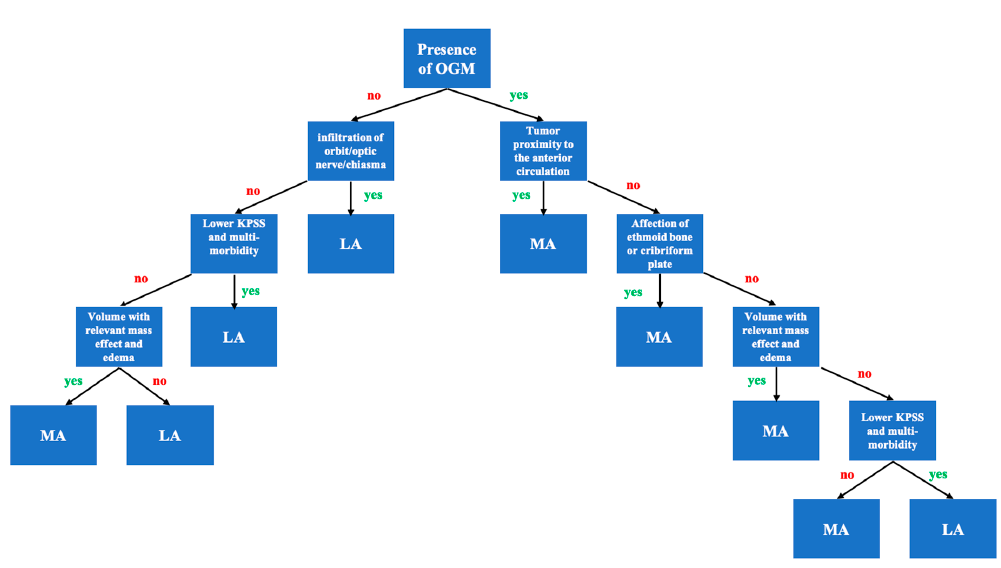
Figure 2. Proposed decision-making algorithm for targeting olfactory groove (OGM), planum